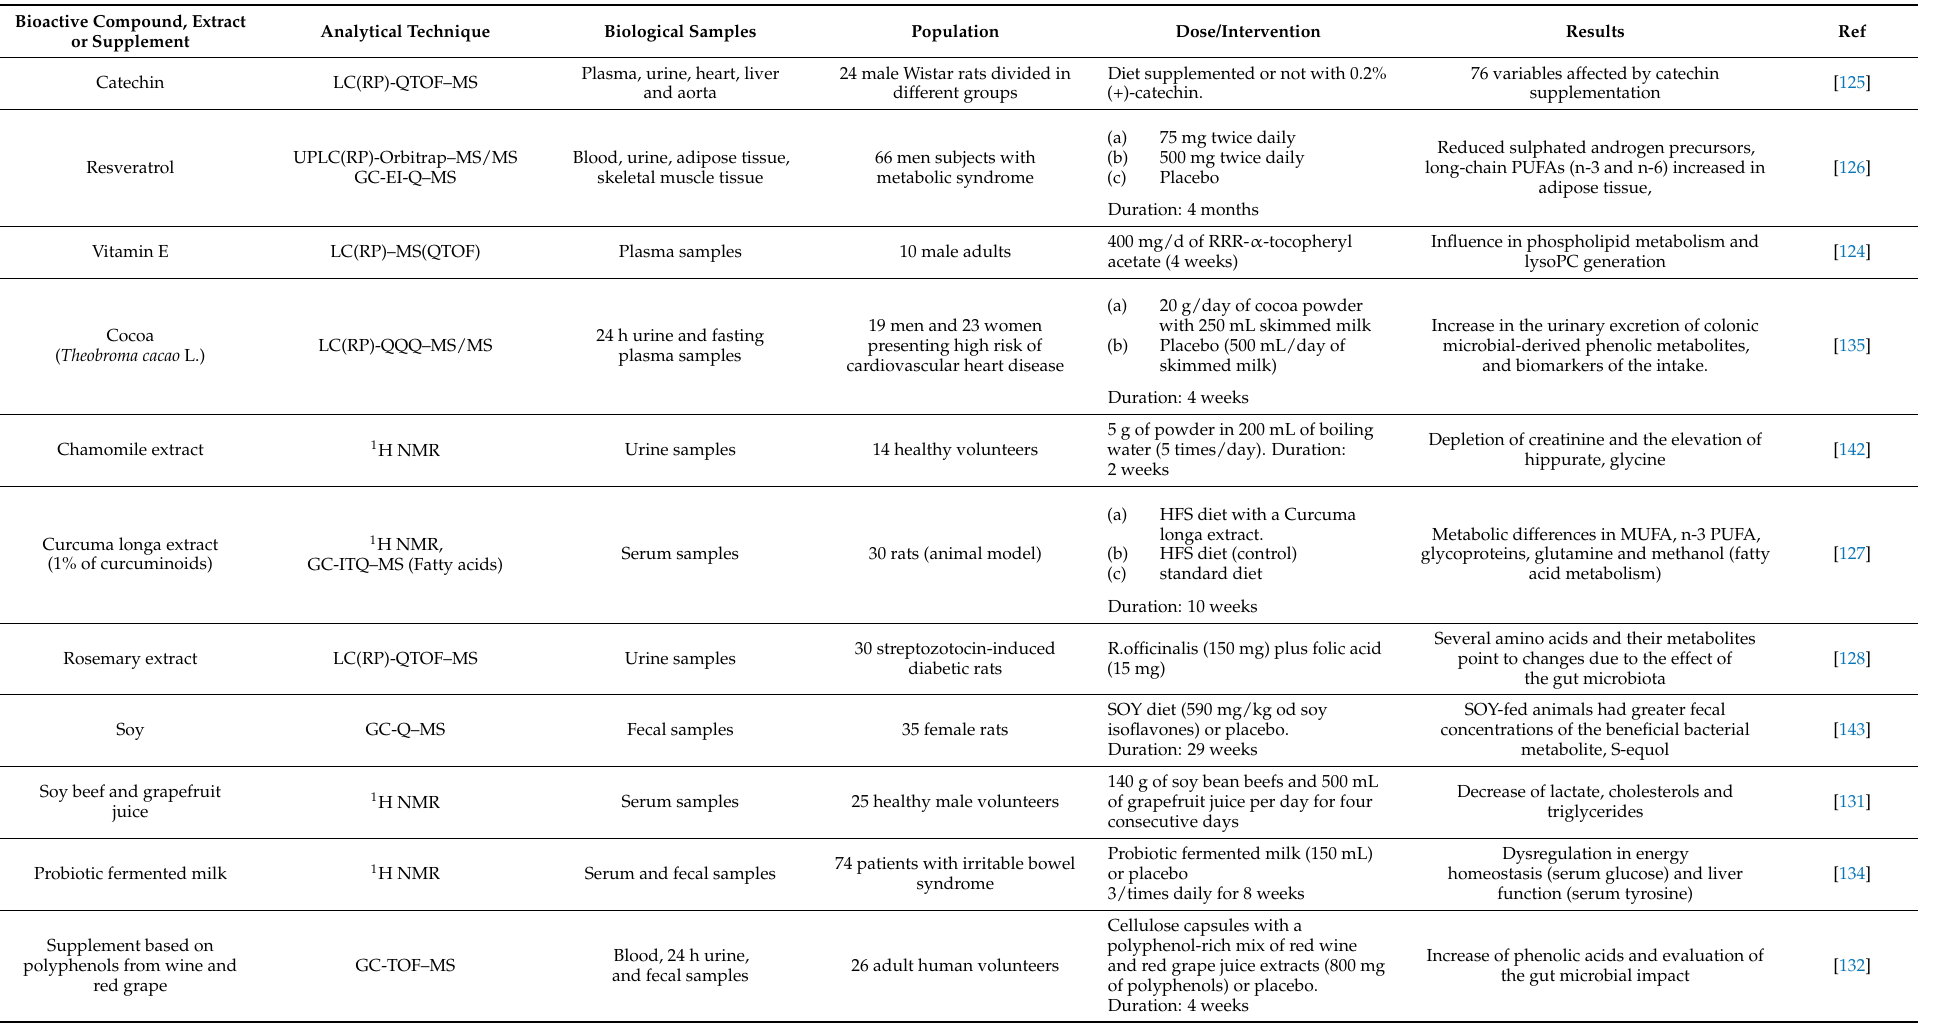
Table 3. Application of analytical approaches in longitudinal nutritional